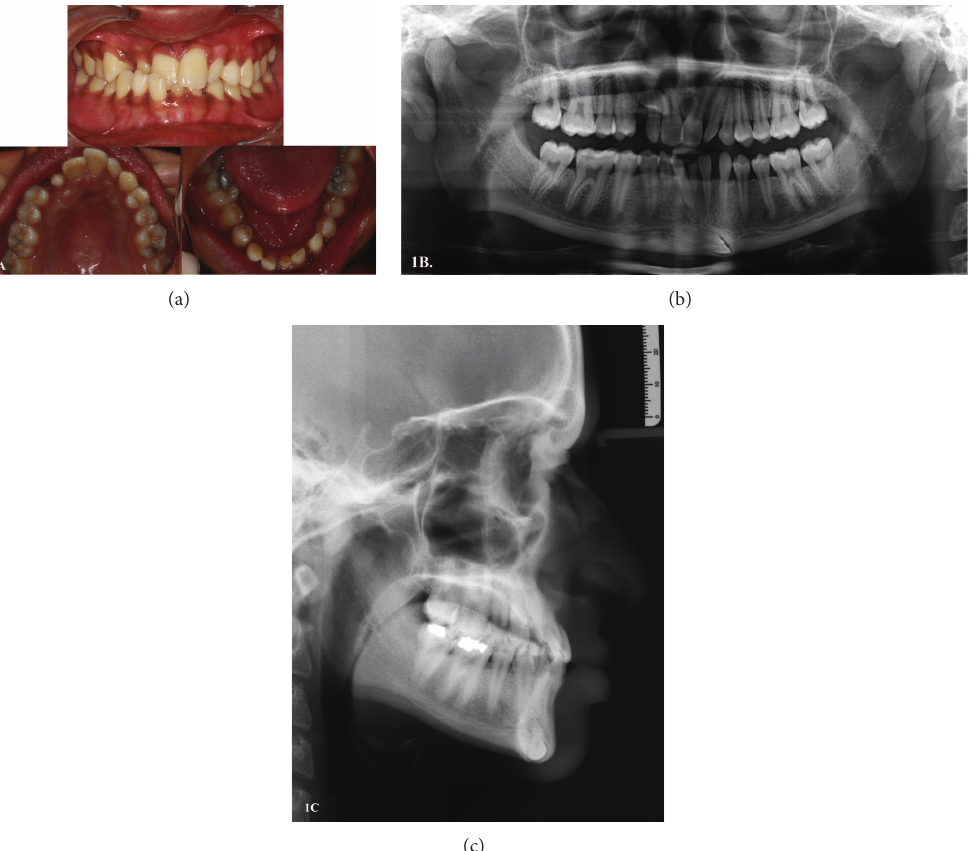
Figure 1: (a)Intraoral photographs showing clinically missing upper right canine, lower right canine and central incisors, and retained deciduous lower right canine and central incisor. (b) Panoramic radiograph showing impacted upper right canine and a reverse obliquely transmigrated lower right canine with its crown piercing the lower border of mandible at the level of opposite canine. (c) Lateral cephalogram showing obliquely lying lower right canine near the lower border of